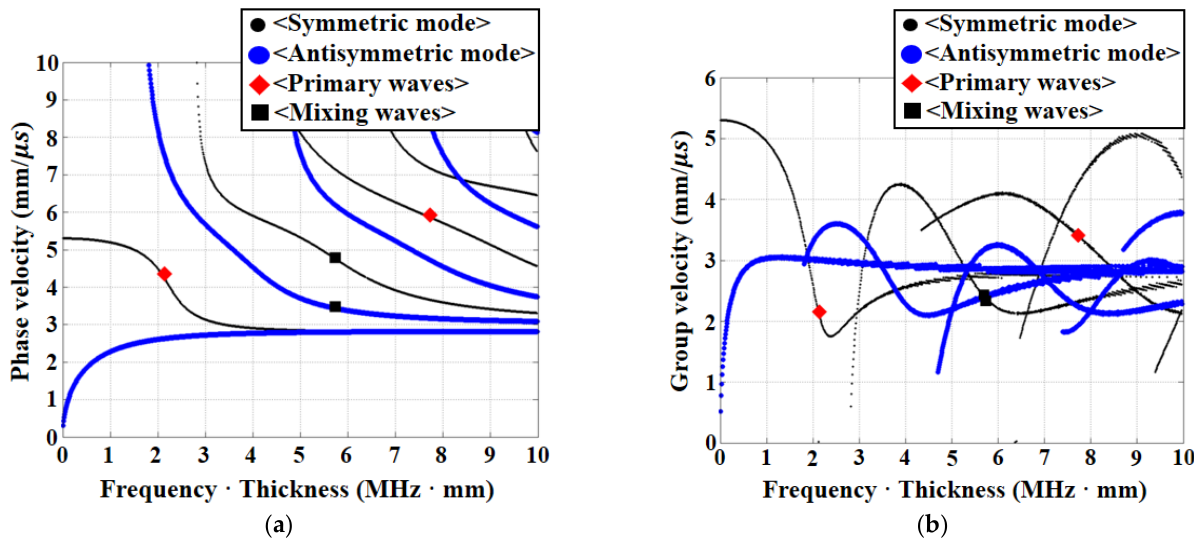
Figure 5. Dispersion curve showing primary and mixing waves: ( a ) Phase velocity; ( b ) Group velocity.